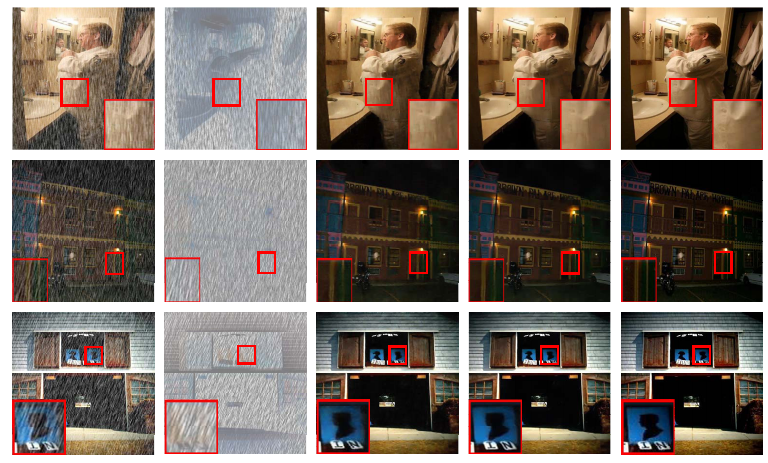
Figure 8. Several example of proposed model. From left to right are: input, rain map, output of generator, output of RFN, ground truth.